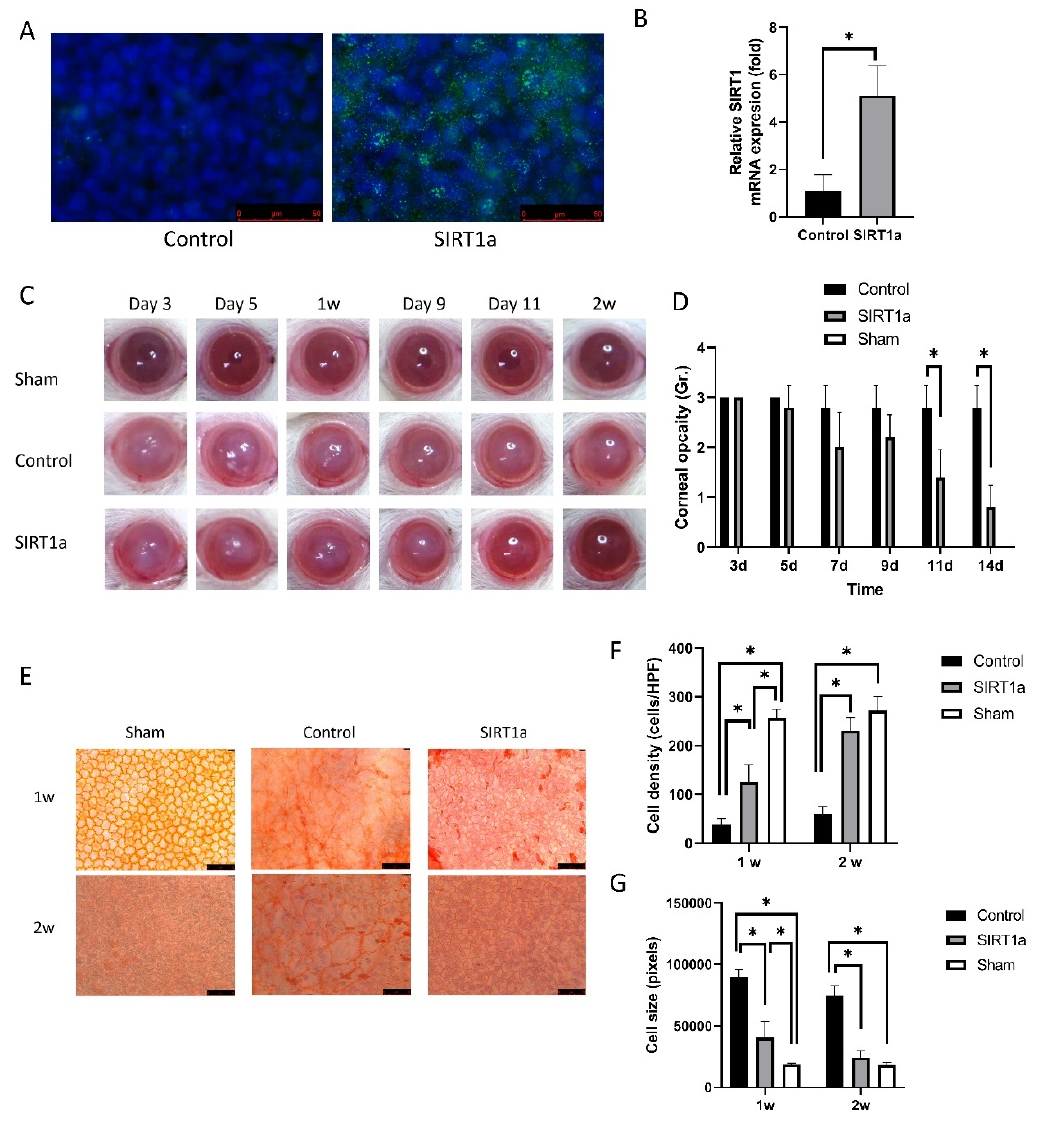
Figure 3. Animal study of SIRT1 activation using CRISPR/dCas9 in rat corneal endothelial cells (CECs). ( A ) Immunofluorescence staining of SIRT1 showing SIRT1a overexpression in SIRT1a group. ( B ) Real-time quantitative polymerase chain reaction (qRT-PCR) showing that relative SIRT1 mRNA expression was elevated to 246.7% of the control group. ( C , D ) Corneal opacity in SIRT1a group was decreased compared to control group on days 11 and 14. ( E – G ) Alizarin red S staining showed higher cell density of CECs at the center in the SIRT1a group compared to the control group, as well as smaller cell size in the SIRT1a group compared to the control group. All experiments were performed in triplicate or quadruplicate. * for p < 0.05 using independent t -test.